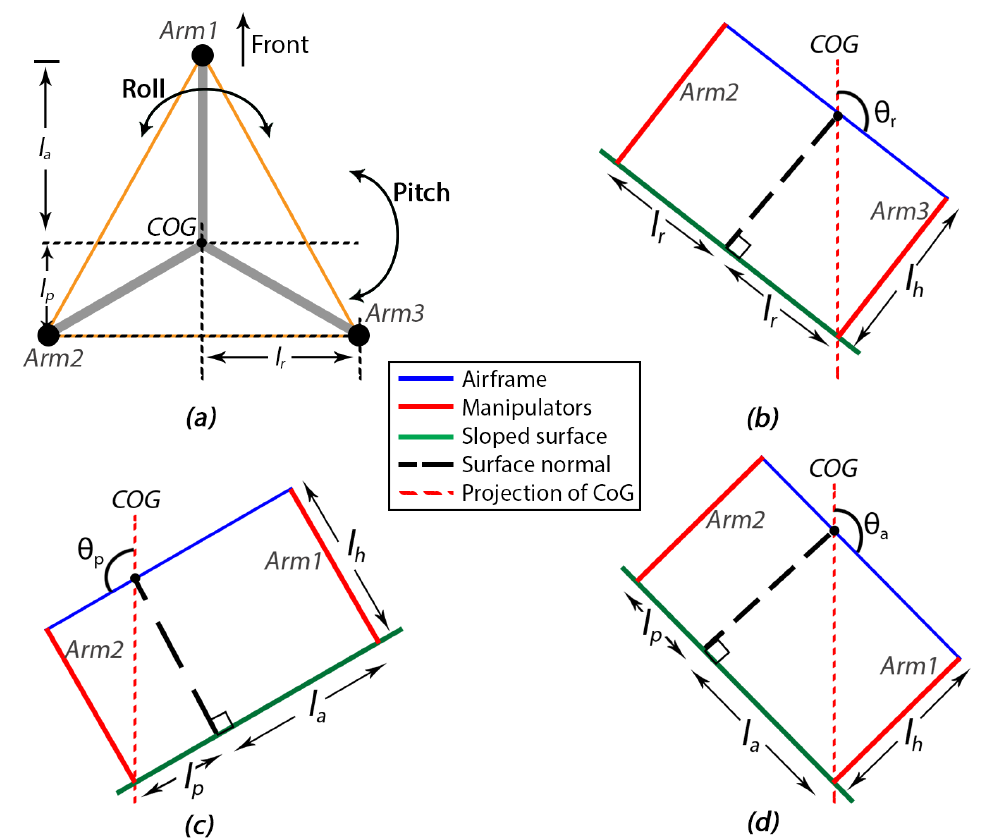
Figure 7. Maximum angles in roll and pitch axes of the airframe before it loses ground stability. ( a ) Roll and pitch axes of the UAV, its support polygon and manipulator labels. ( b ) Side view of COG reaching the boundary for the roll angle. ( c , d ) Side view of COG reaching the boundary for the pitch angles, when Arm 2 ( c ) or Arm 1 ( d ) side of the UAV is pointing